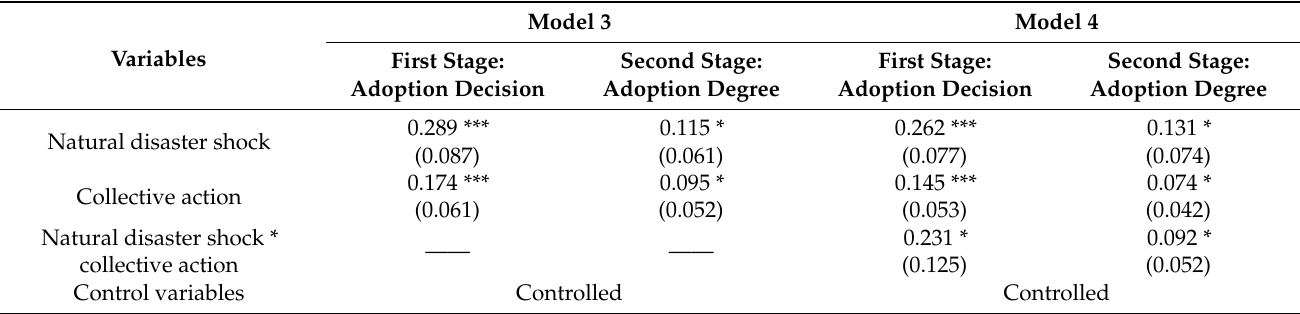
Table 7. Results of the robustness